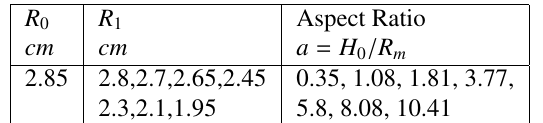
Figure 1. Schematic of a glass-made cone partially filled with a granular material, the dimensions of the cone are given in the upper drawing. When the glass cone is suddenly removed, the released conical column slumps onto a flat bottom plane and the new dimensions of the resulting cone are given in the lower drawing.